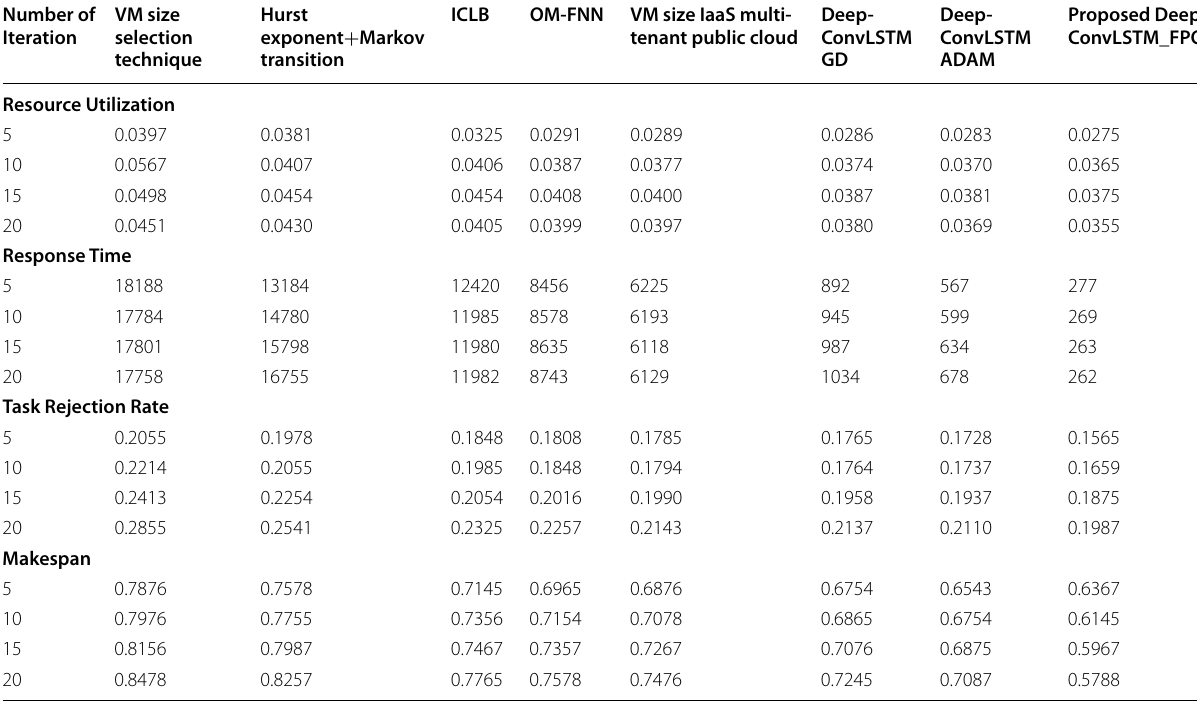
Table 6 Comparative Assessment of Deep-ConvLSTM_FPO Scheme With Task Size 100 Number of Iteration